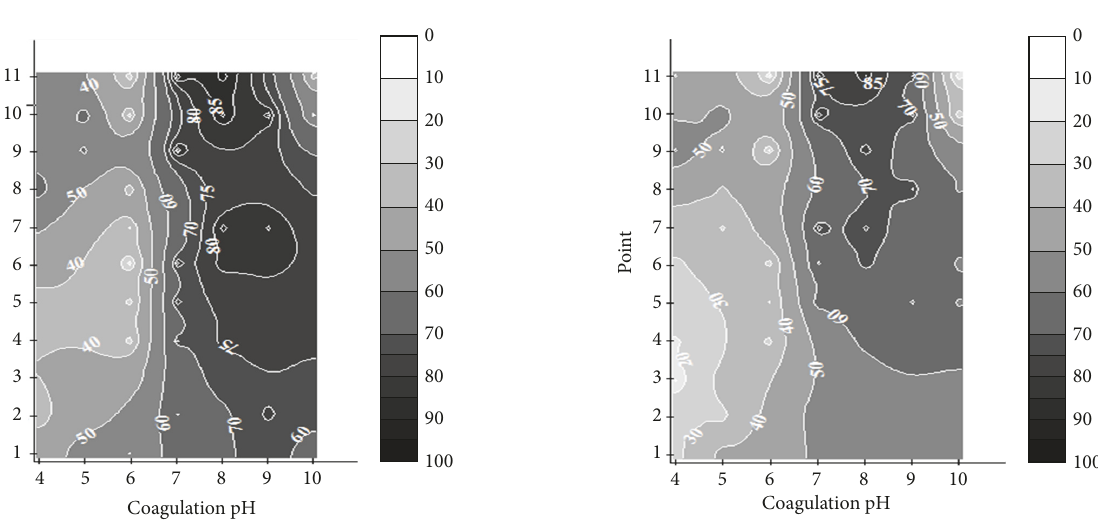
Figure 4: Coagulation diagrams with curves of apparent color removal in percentage (%).